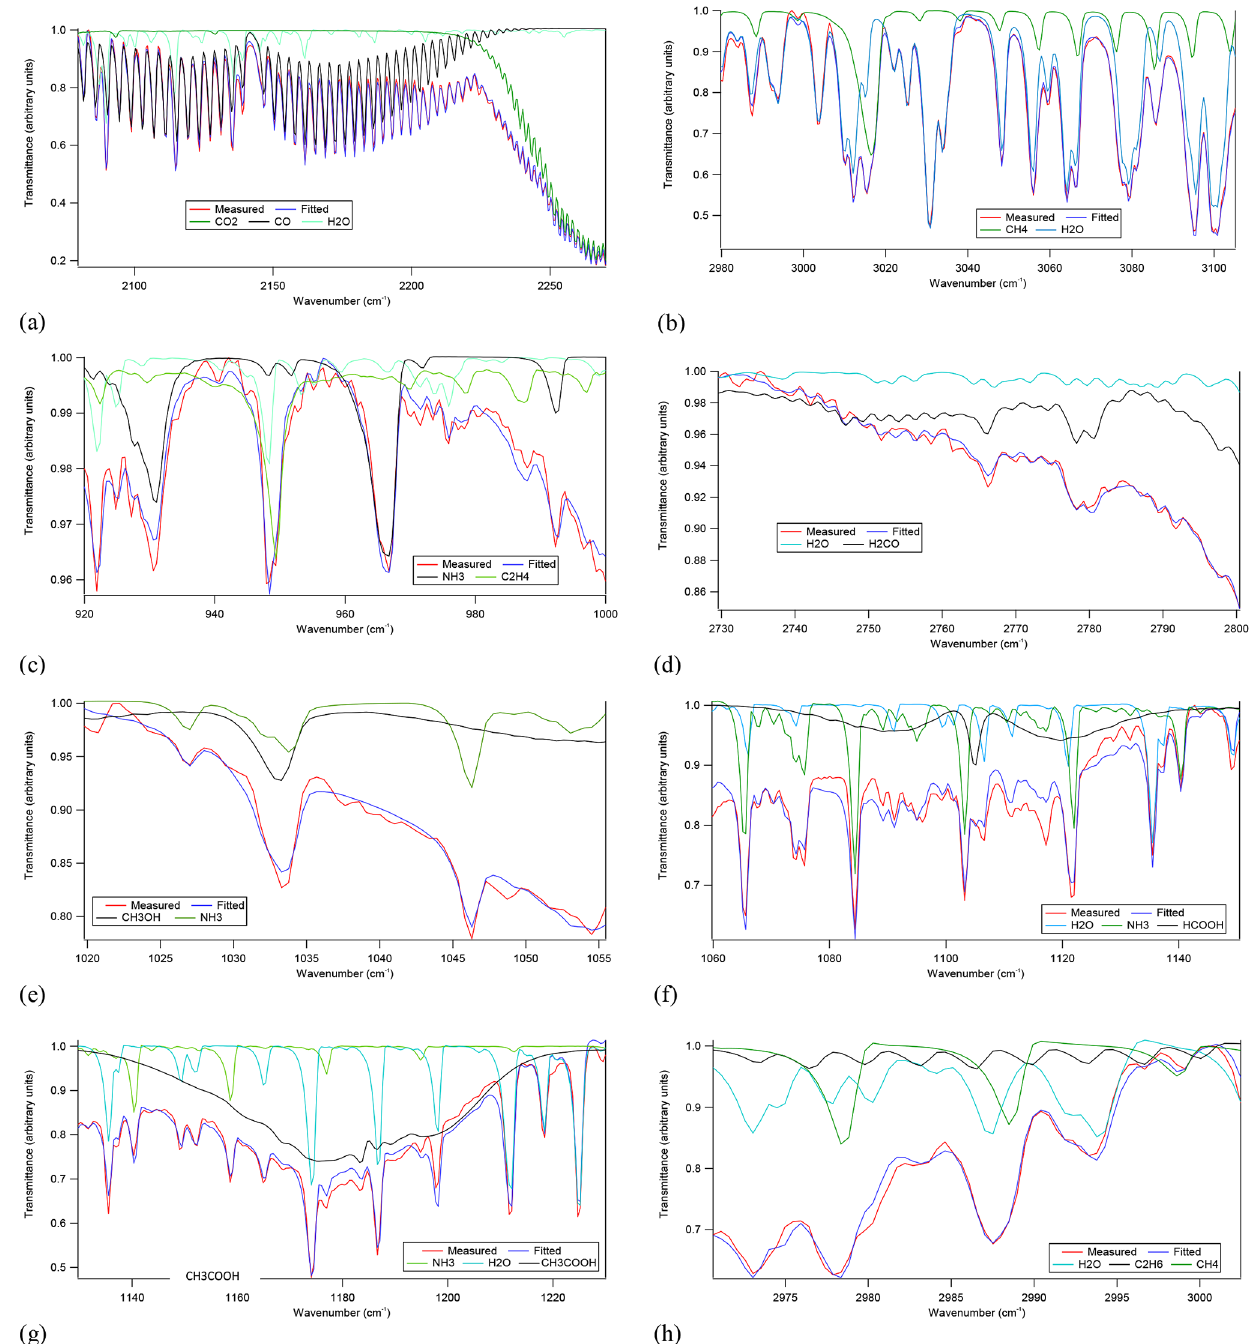
Figure 2. Plots of MALT fits of simulated to measured spectra. The main gases contributing to the absorption features in each spectral region are also